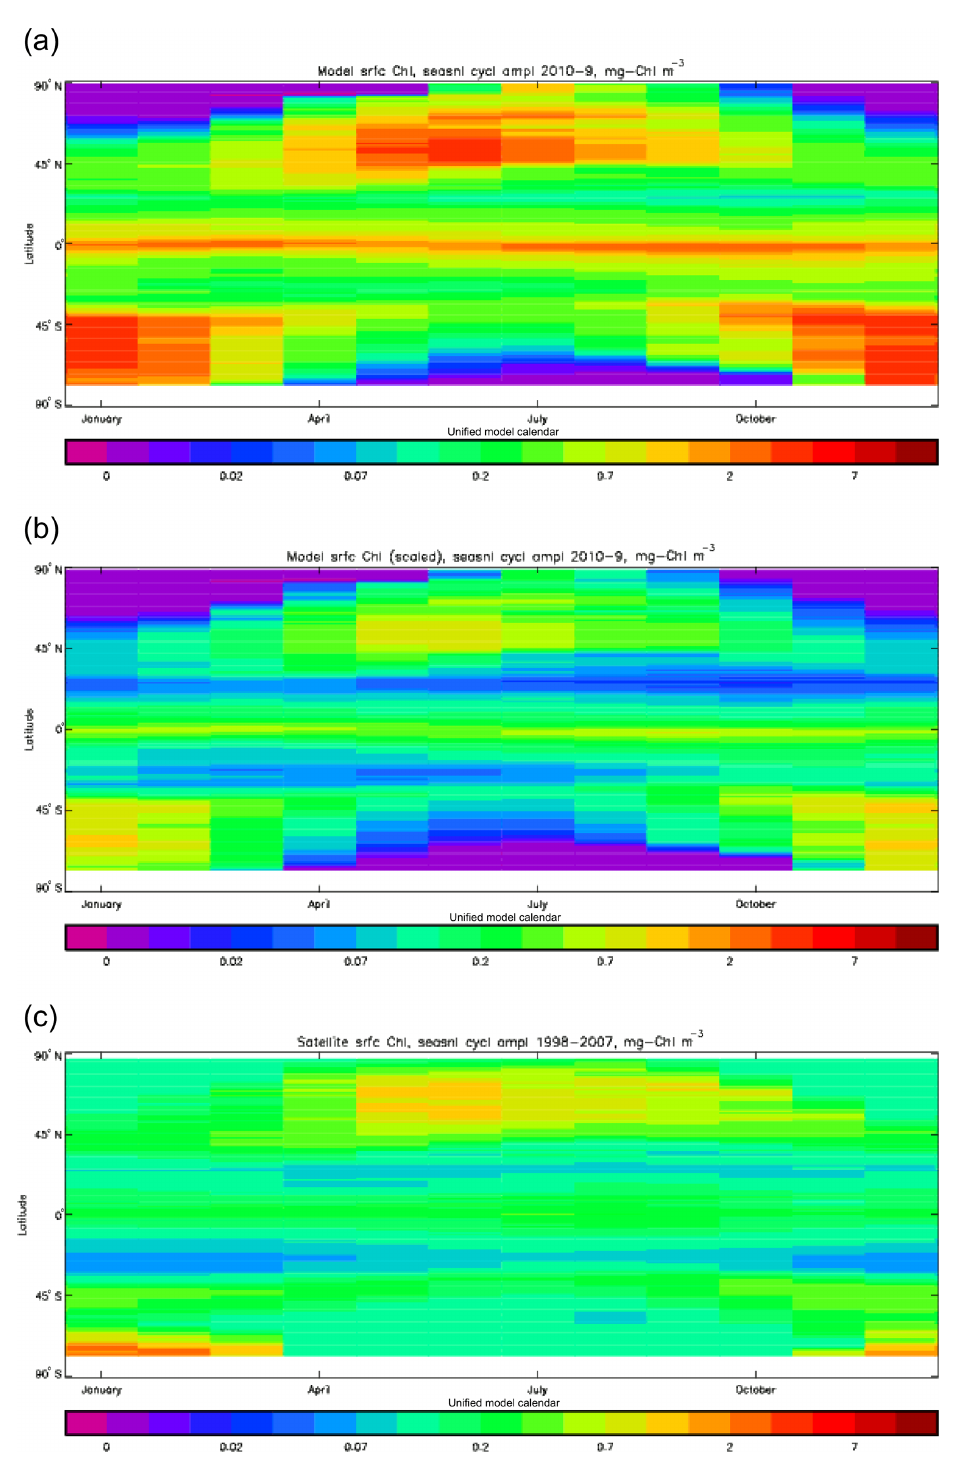
Figure 3. Seasonal cycle of global zonal mean surface chlorophyll (mgChlm − 3 ): (a) average over the years 2010–2019 from the model, historical + RCP8.5 scenario; (b) the same but scaled by factor 0 . 213 / 0 . 812 ( = 0 . 262 ) so that the model mean matches the observations; (c) satellite-derived data from GlobColour, averaged over